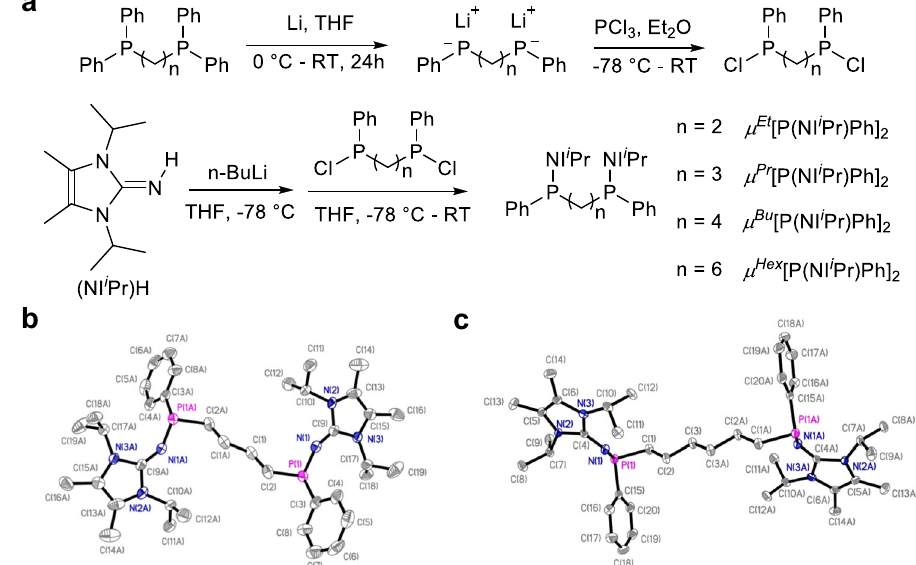
Fig. 2 Synthesis and structures. a synthetic route for bis(imino)phosphine superbase. b X-ray crystal structure of μ Bu [P(NI i Pr)Ph] 2 . P(1)-N(1) 1.655(5) Å, C(9)-N(1) 1.334(6) Å, C(9)-N(2) 1.367(6) Å, C(9)-N(3) 1.388(5) Å. c X-ray crystal structure of μ Hex [P(NI i Pr)Ph] 2 . P(1)-N(1) 1.6731(16) Å, C(4)-N(1) 1.300